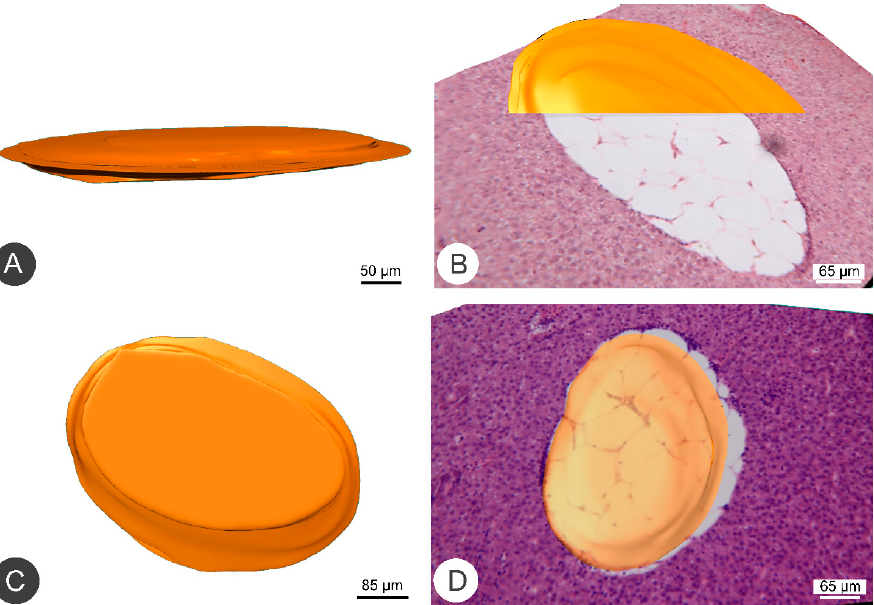
Figure 3. Three-dimensional (3D) reconstructions ( A , C ) of the intrahepatic adipose cell agglomerate, side by side with two “bi-dimensional” aspects ( B , D ). The last images have digital overlays (in orange) partially superimposed on the histological picture to explain how each histological image contributes to building the serial stack. The microlipoma flattened oval shape became evident when viewing the 3D reconstruction at different angles.